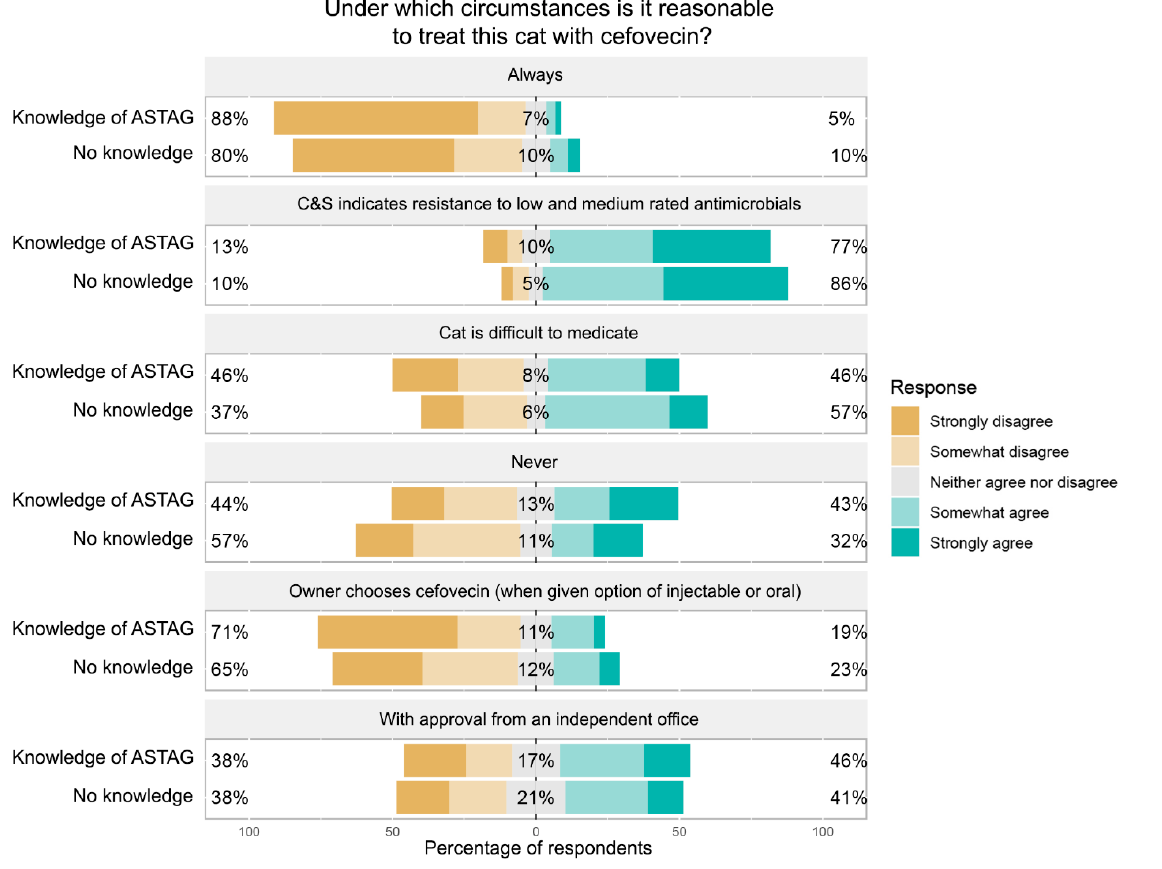
Figure 4. Responses of participants about the reasonableness of use of cefovecin in different circum- stances, with responses segregated based on the respondents’ knowledge of the ASTAG rating sys- tem.